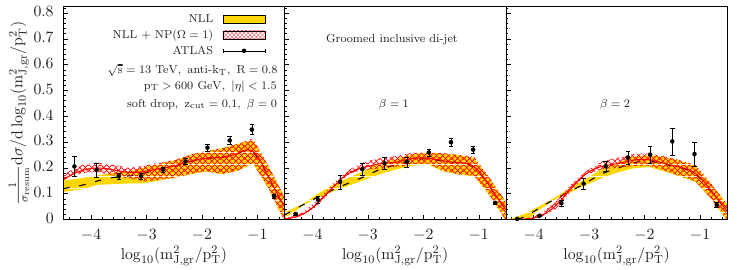
Figure 3. Comparison with the ATLAS data [26] for the soft drop groomed jet mass distribution at √ s = 13 TeV.